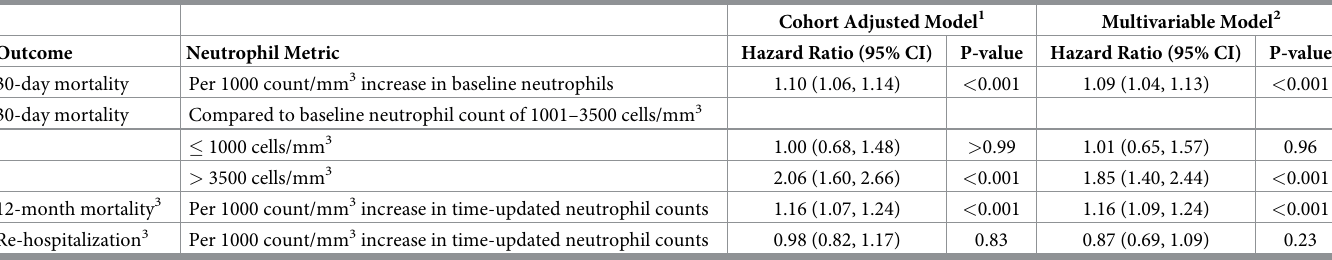
Table 3. Model associations between neutrophil counts and